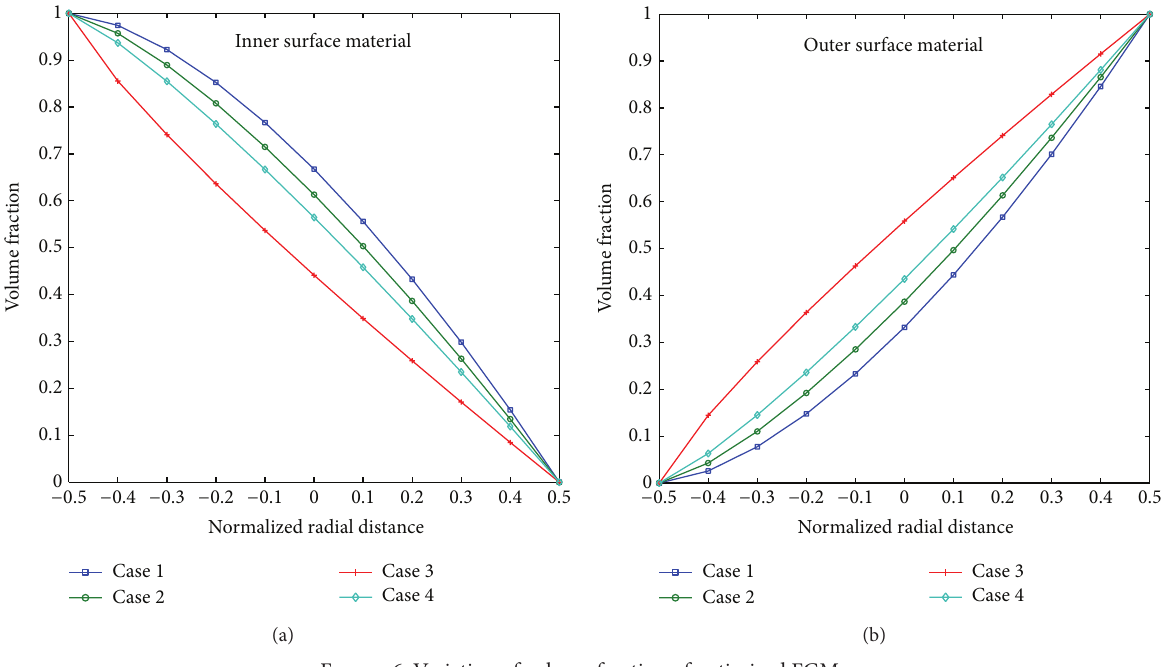
Figure 6: Variation of volume fraction of optimized